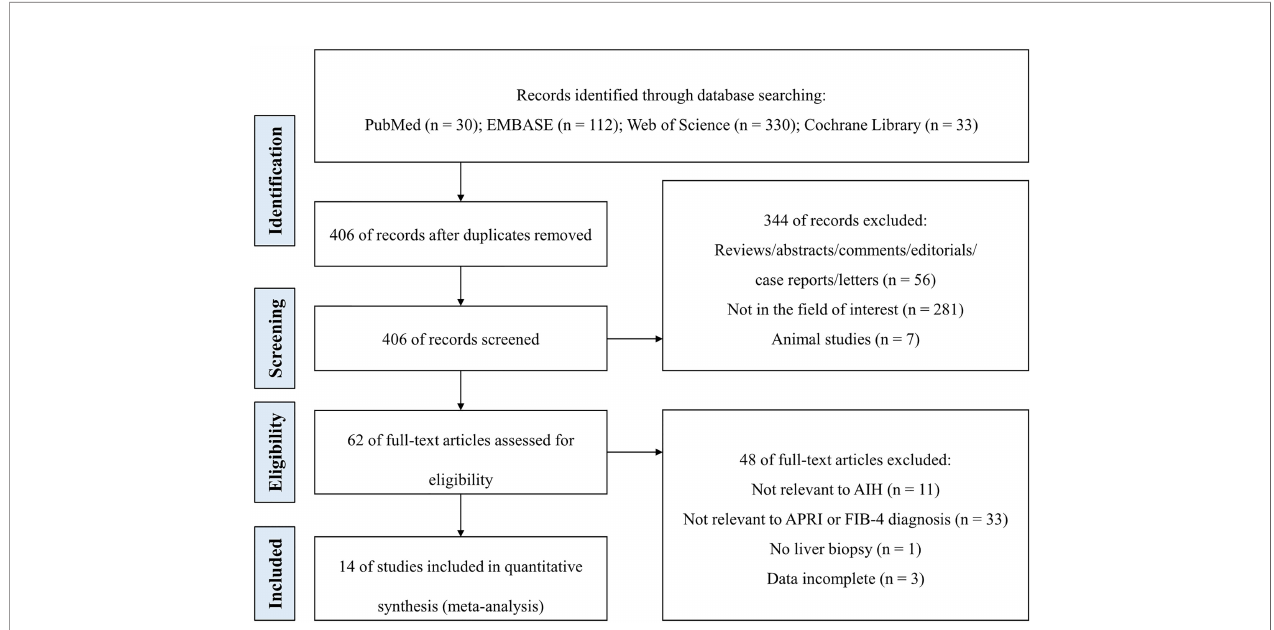
FIGURE 1 | The study fl ow